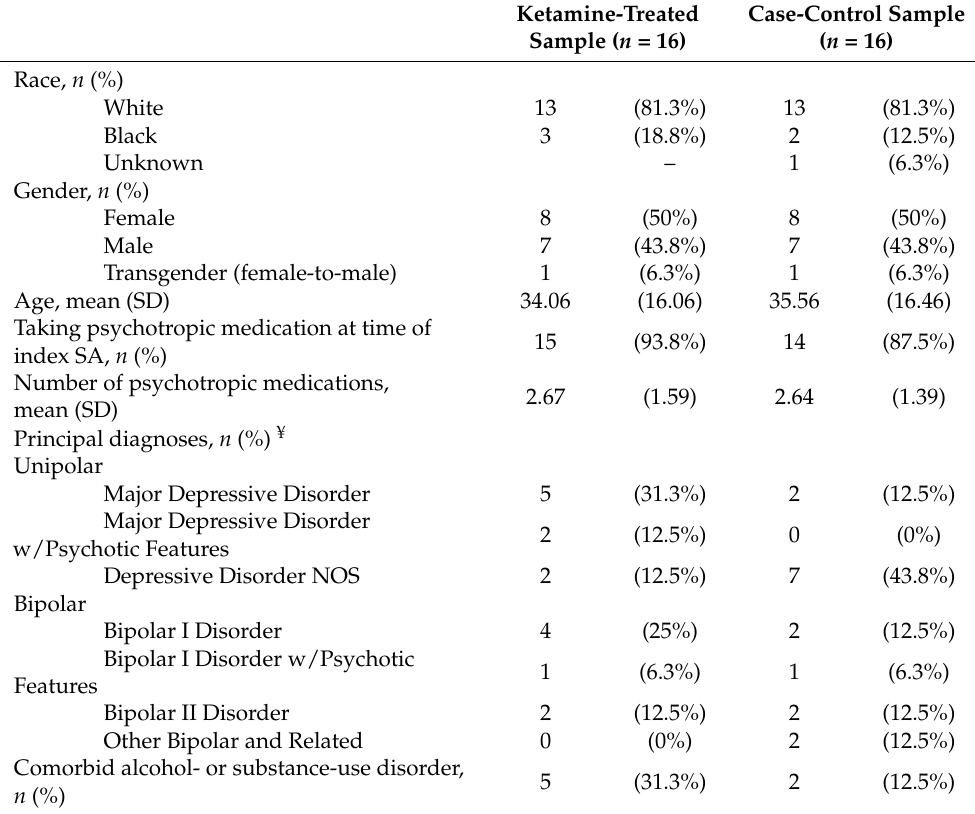
Table 1. Baseline demographic and clinical characteristics of the ketamine-treated sample and the case–control